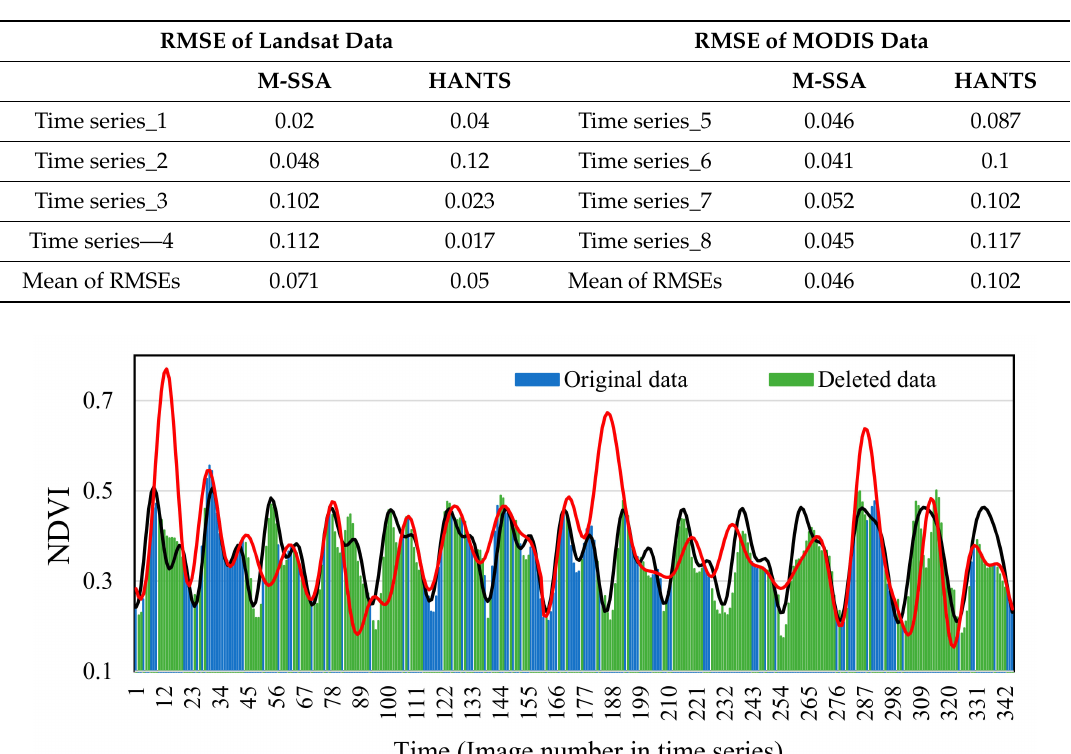
Figure 19. Correlation of original image with reconstructed image in HANTS algorithm ( a ) and M-SSA algorithm ( b ). Table 3. RMSE between original and reconstructed time series by M-SSA and HANTS using Landsat (Time series 1 to 4) and MODIS (Time series 5 to 8).